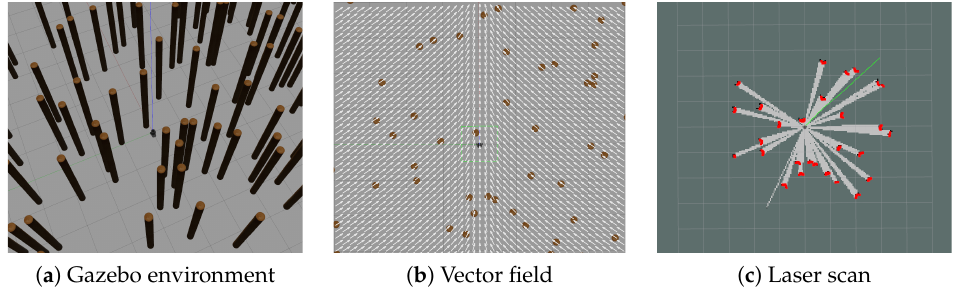
Figure 13. Experimental setup used to compare the performance of the parallel and serial versions of the SSLAT motion planner. In ( a ), the environment was constructed using cylindrical objects in Gazebo, to simulate a forest. The global task is encoded by the vector field in ( b ), which follows a straight line in the vertical direction. In ( c ) it is possible to see, in a specific robot position, the valid LIDAR scans (i.e., within the sensor range) used to prune the search